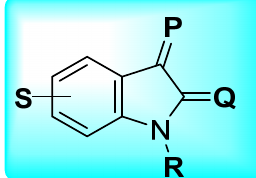
Figure 11. Isatin motif with its substituting positions.